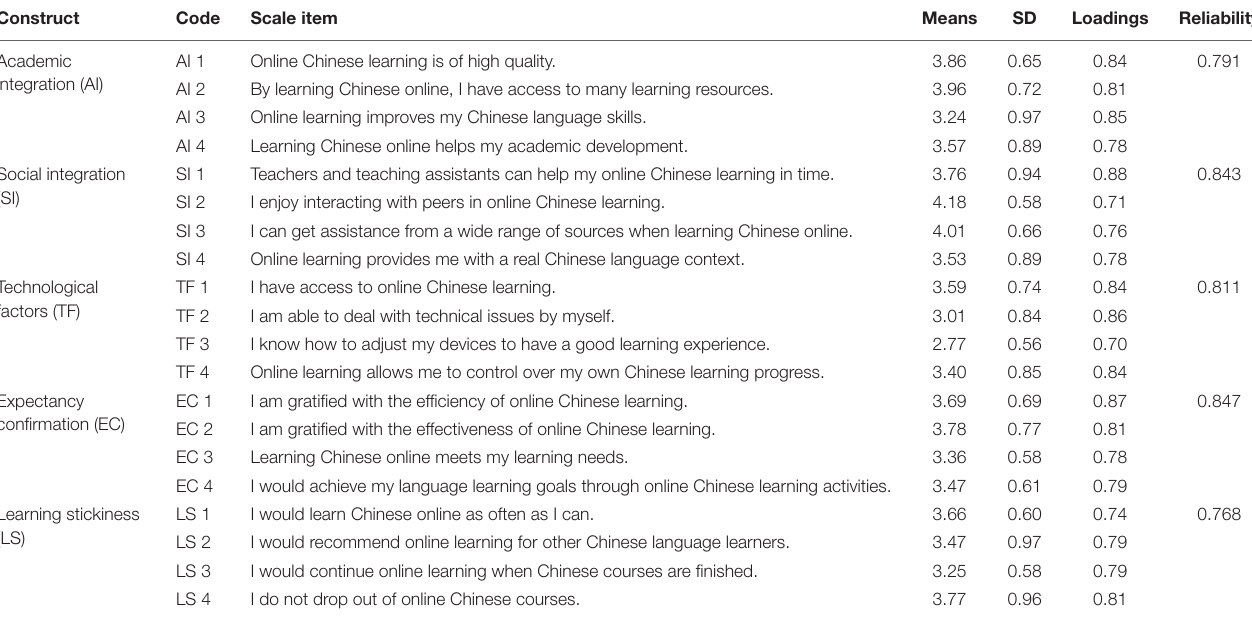
TABLE 3 | Descriptions, loadings, and internal reliability of scale items.